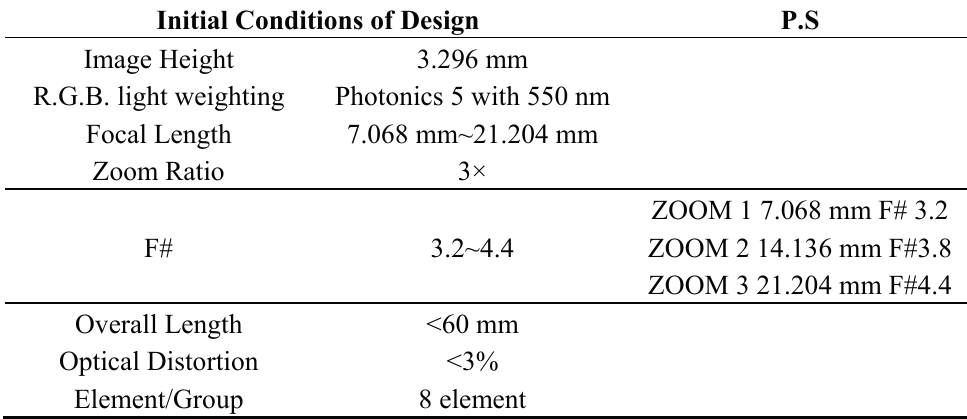
Table 2. The specification of the front zoom lens.